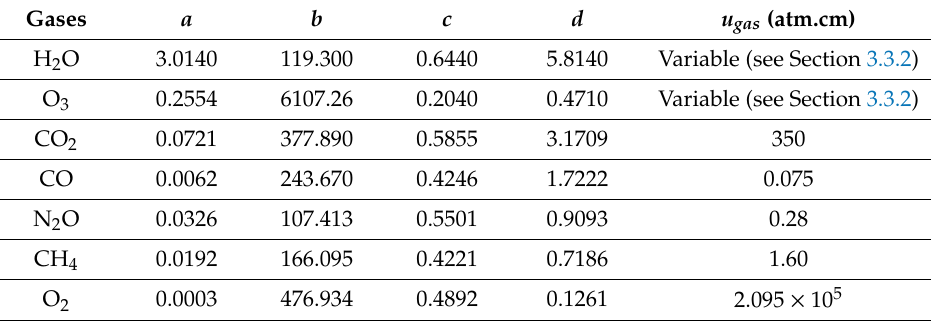
Table 3. Coe ffi cients a, b, c, and d used to compute the shortwave gases transmittances; from references